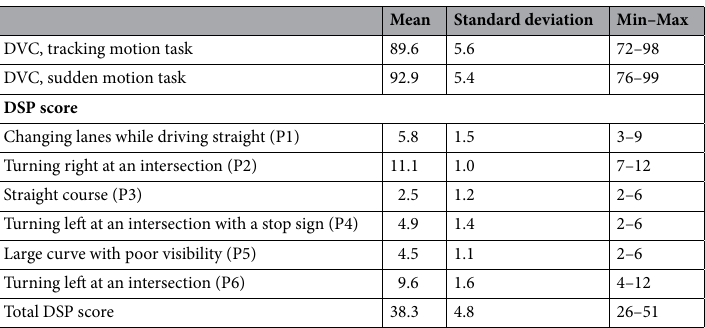
Table 2. Descriptive characteristics of DVC tests and DSPs using actual vehicles. DVC dynamic visual cognition, DSP driving safety